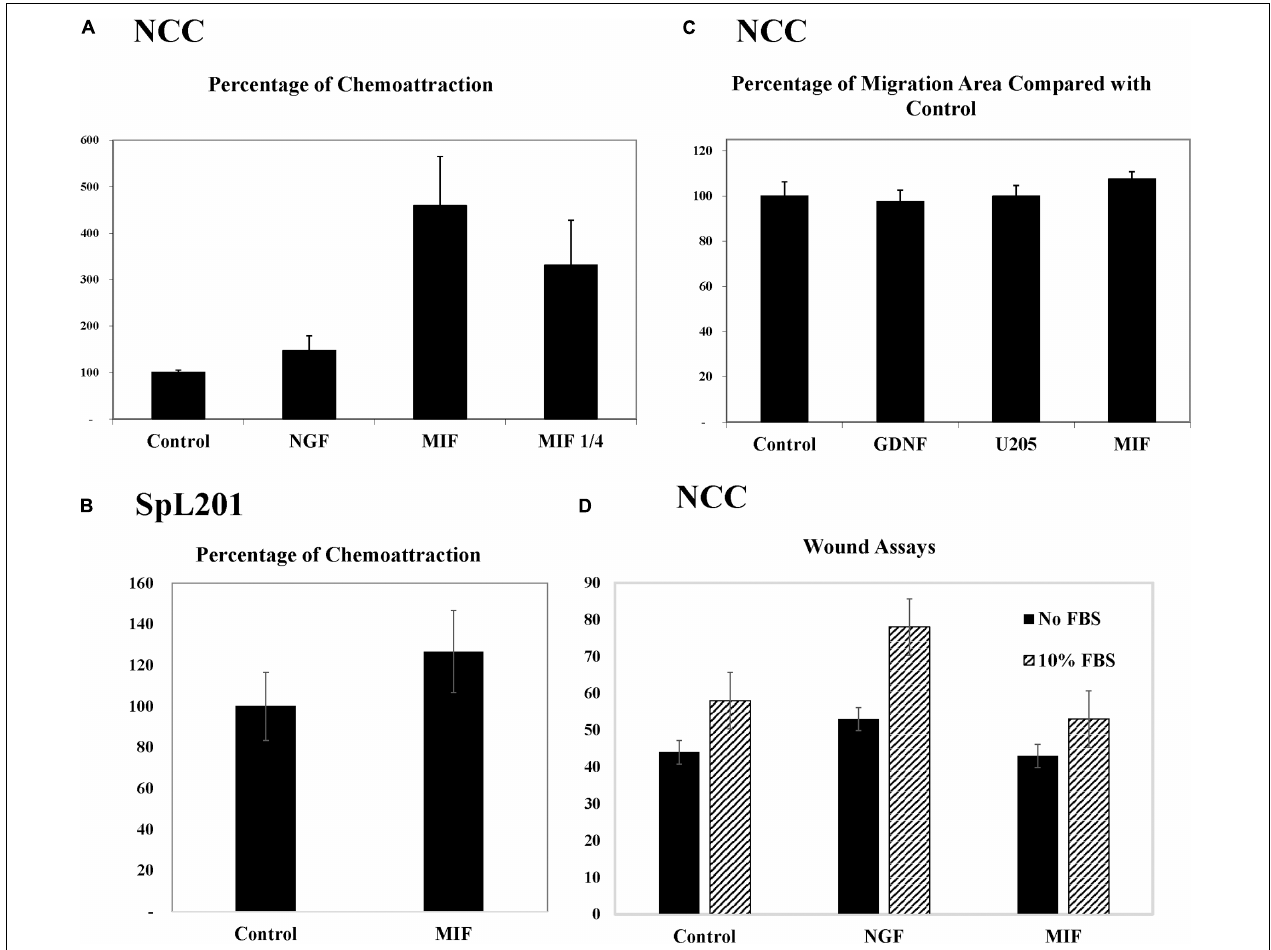
FIGURE 10 | MIF attracts tNCC in vitro . (A) Isolated tNCC were seeded on top of Boyden chambers in the presence or absence of MIF and NGF. Number of cells were counted after 5 h of incubation. Data has been normalized to control numbers of tNCC in control wells (no chemokine present in bottom well. There were ∼ 4.5 times more tNCC in MIF wells compared with control or NGF. Diluting MIF to 1/4 decreased attraction by 35%. (B) Spl201 cells were exposed to MIF in bottom wells as performed for tNCC. (C) Isolated tNCC cultures were exposed to control media (control), U205 conditioned media or U205-MIF conditioned media overnight. The maximum migrated distance was measured. Graph shows results from 10 experiments combined and normalized to control media. (D) Isolated tNCC cultures were wounded and exposed to control media (control), NGF or U205-MIF conditioned media in the presence or absence of FBS in the media. Data in graph corresponds to number of cells in the wounds after 2 h of incubation. There was no statistical difference between all three treatments compared across. Only the presence of FBS increased wound healing in tNCC cultures, but there was no difference between control and MIF